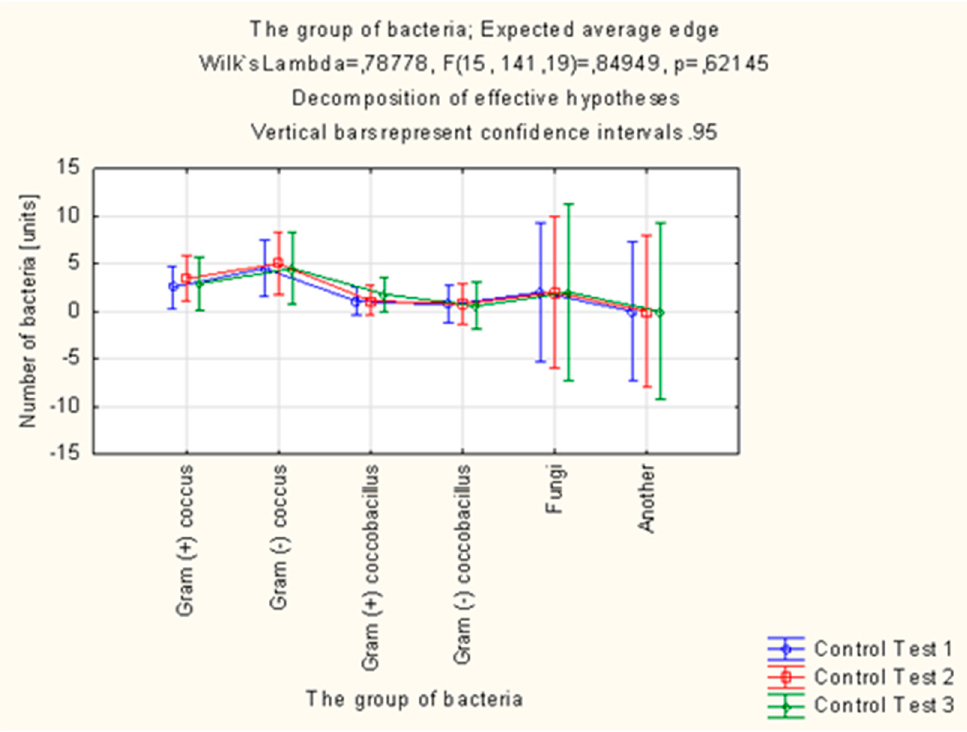
Figure 5. Distribution of isolated microorganisms in the control group.